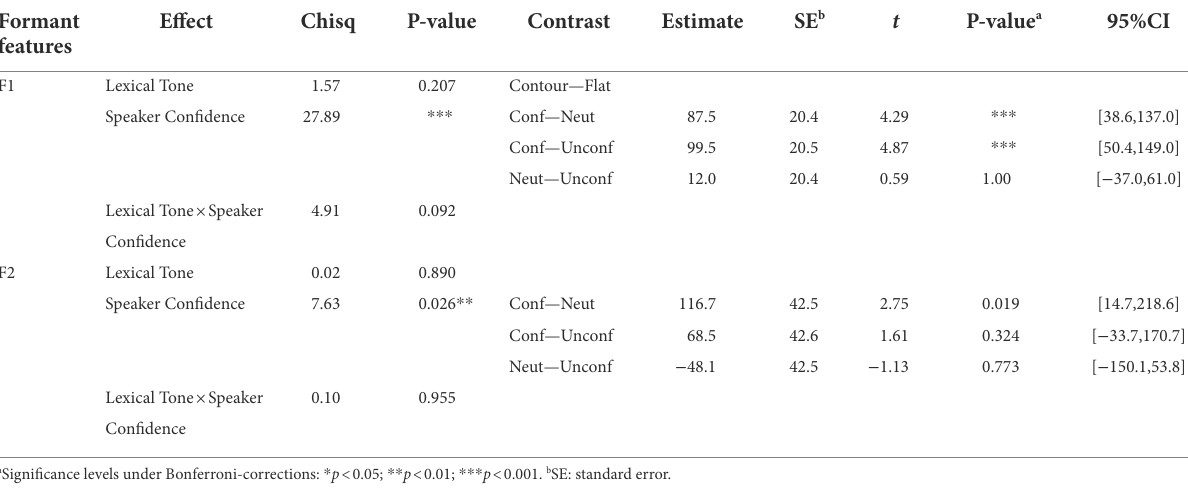
TABLE 2 LME model performances for formant features.